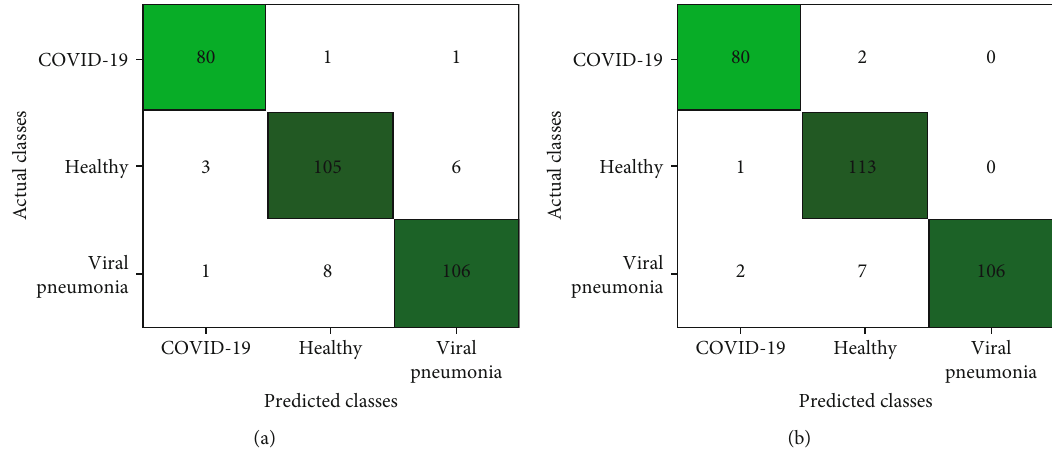
Figure 7: Confusion matrix of (a) DenseNet169 and (b) InceptionV3. Table 7: General comparison of the best CNN obtained with state-of-the-art